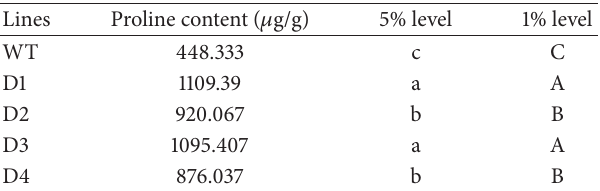
Figure 1: The influence of salt stress on transgenic lines and WT plants. 1: WT plants without stress; 2: transgenic lines D1 after 3 days of salt stress; 3: WT plants after 3 days of salt stress. WT represents the untransformed wheat variety Ningmai 13. Table 1: Proline content in the WT plants and SbPIP1 gene transgenic lines after 3 days of 250 mM NaCl treatment.